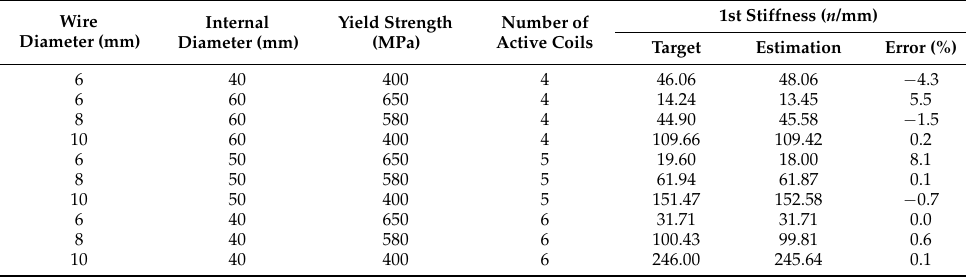
Table 6. Estimated results of ANN2.